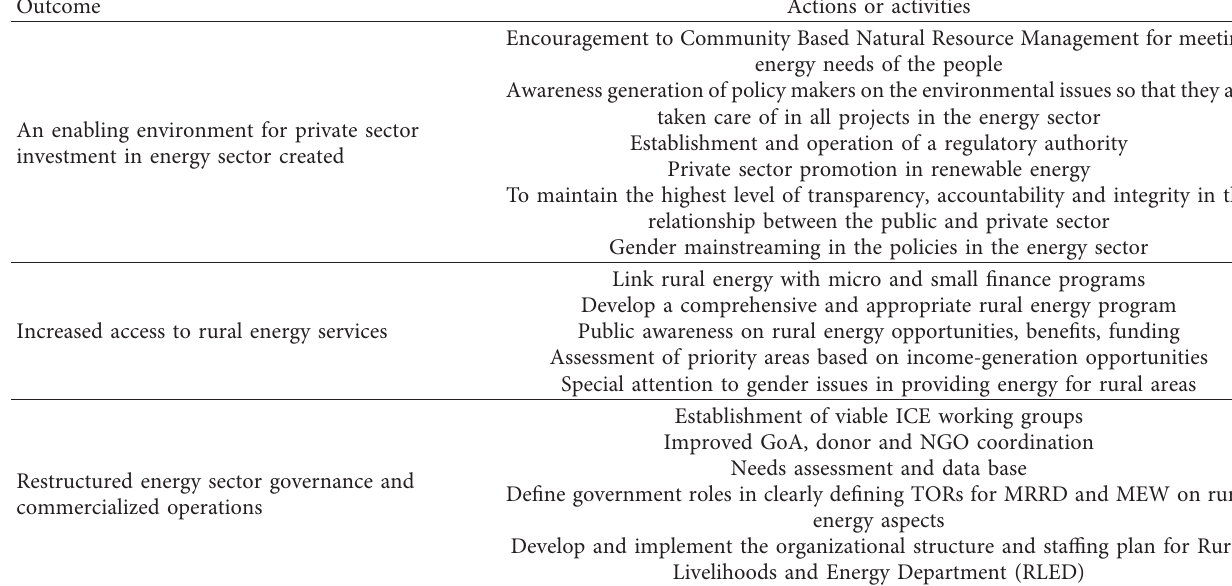
Table 4: Parts of Energy Sector Strategy (ESS) action plan [26].